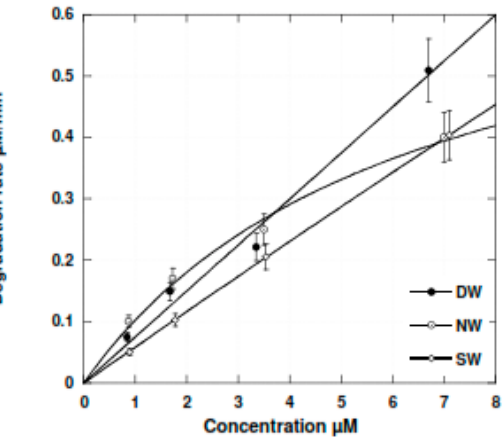
Figure 8. BT degradation rate in deionized, natural and synthetic sea water at the lowest concentrations; 352 kHz; volume = 300 mL; temperature = 21°C ± 1°C; electric input = 80 W.